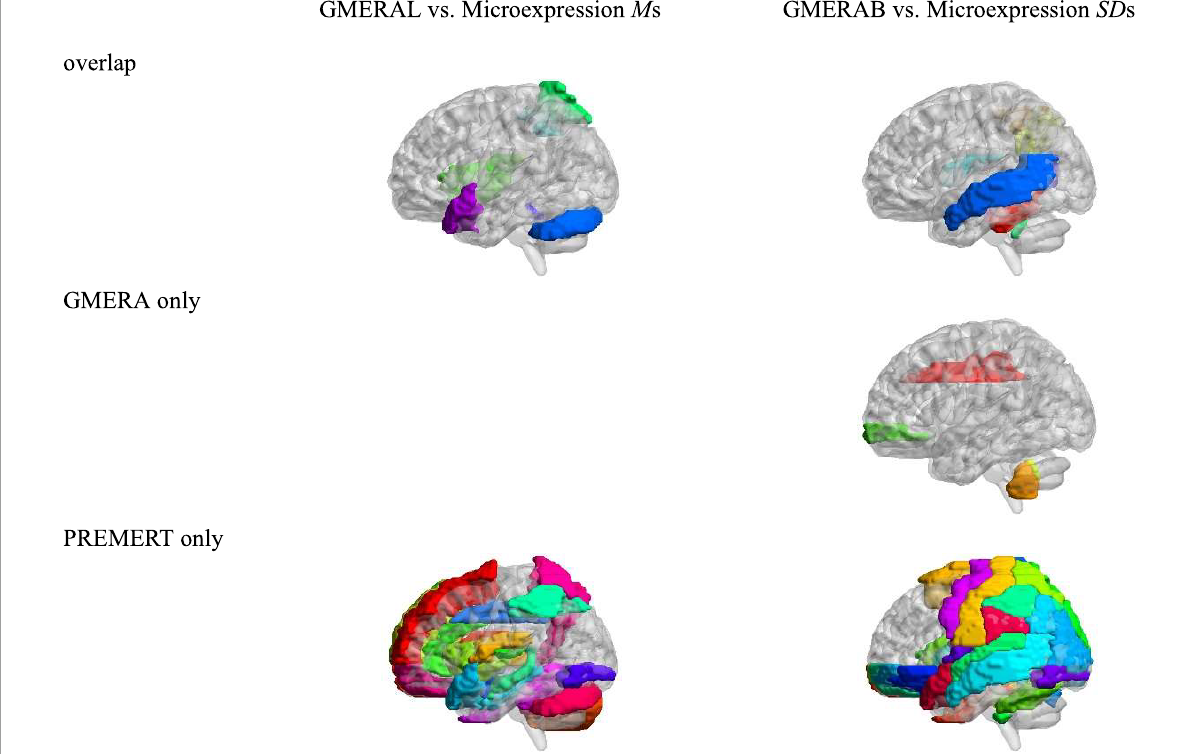
FIGURE3 The overlap of relevant brain areas between GMERAL and Microexpression M s, and between GMERAB and Microexpression SD